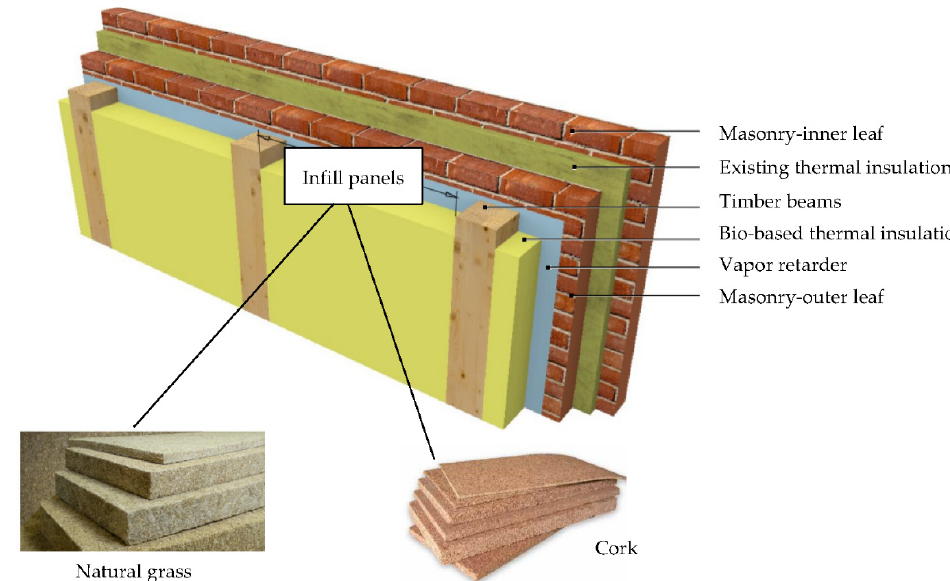
Figure 4. Layer configuration for the installation of Strong Thermal and Seismic Backs using two alternatives for bio-based thermal insulation infill panels: natural grass and cork.